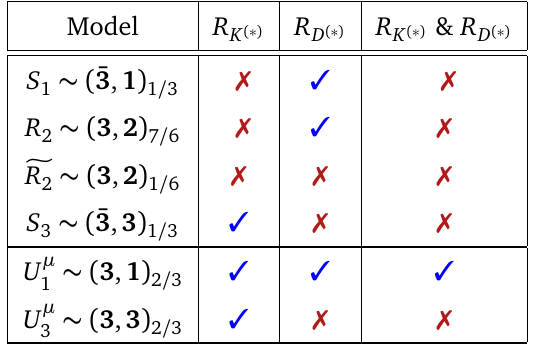
Table 1: Summary of the LQ models which can accommodate R R (second column), and both R D ( ∗ ) phenomenological problems. See Ref. [ 11 ] for